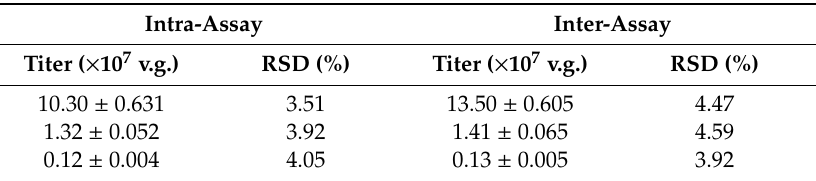
Table 2. Intra-assay and inter-assay precision of VIRELISA.